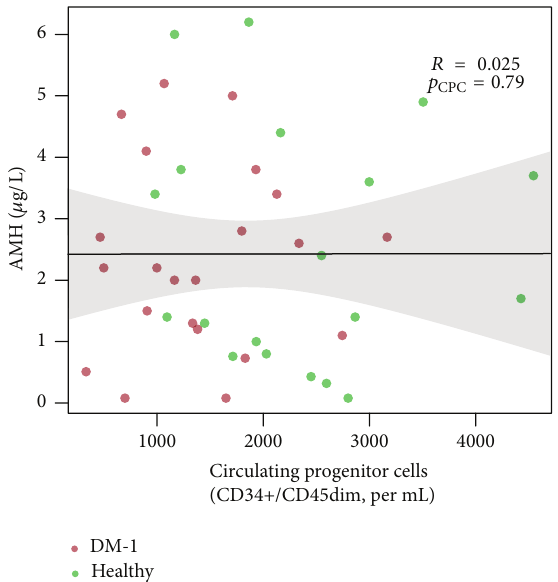
Figure 1: Correlation between AMH and number of CD34+/ CD45dim cells. Number of CD34+/CD45dim cells was not corre- lated with AMH levels (crude 𝑅 = 0.025 , 𝑝 = 0.79 ).